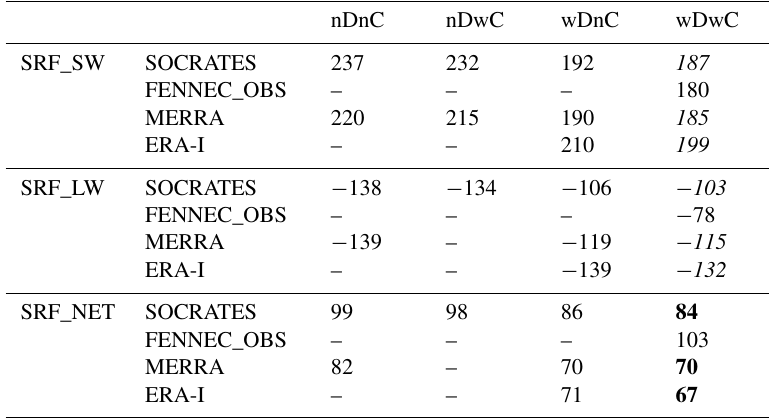
Table 3. Same as Table 2 but for surface radiative flux and observations from the Fennec